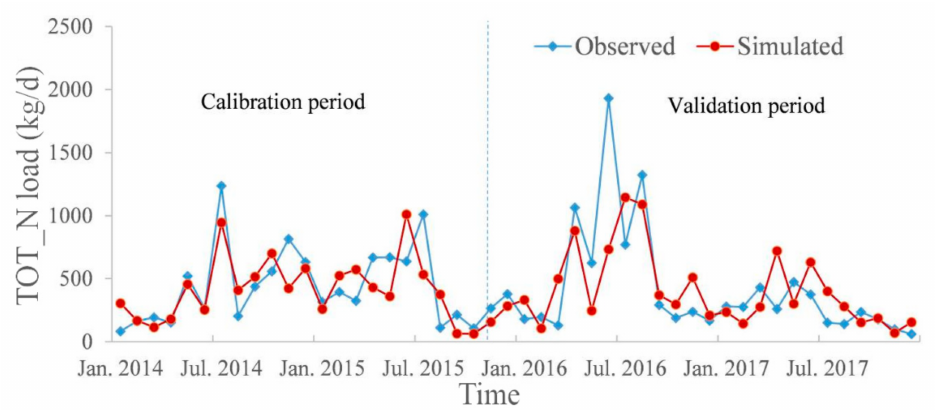
Figure 3. Comparison between simulated and observed result of TOT_N.